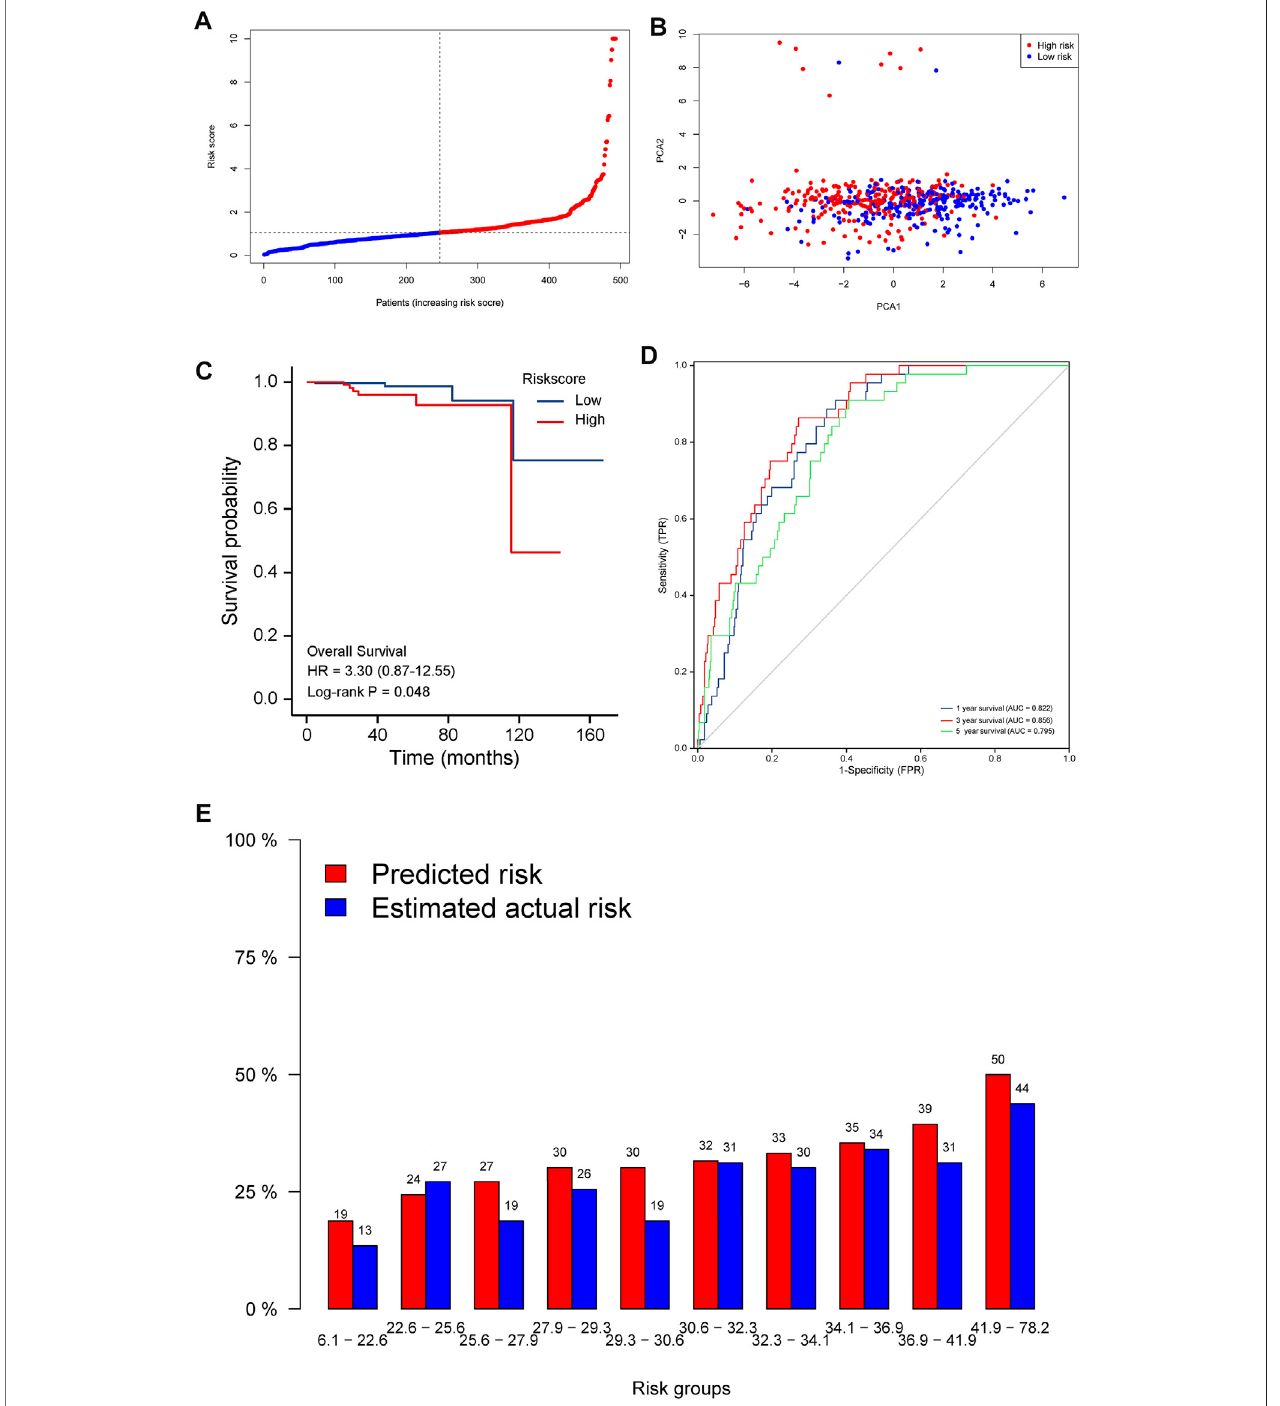
FIGURE 3 | Prognostic value of the 5-gene signature model in the test (TCGA) cohort. (A) . Distribution and median values of the risk scores. (B) . PCA plot. (C) . Kaplan-Meier curvesshowing OS ofpatientsin thehigh-risk and low-risk groups. (D) . AUC values ofthe time-dependent ROC curves showing prognostic performance of the risk score. (E) . Calibration plots for the established